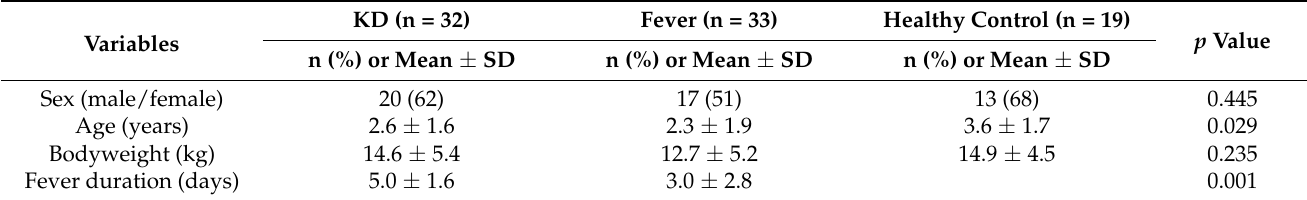
Table 1. Patient baseline